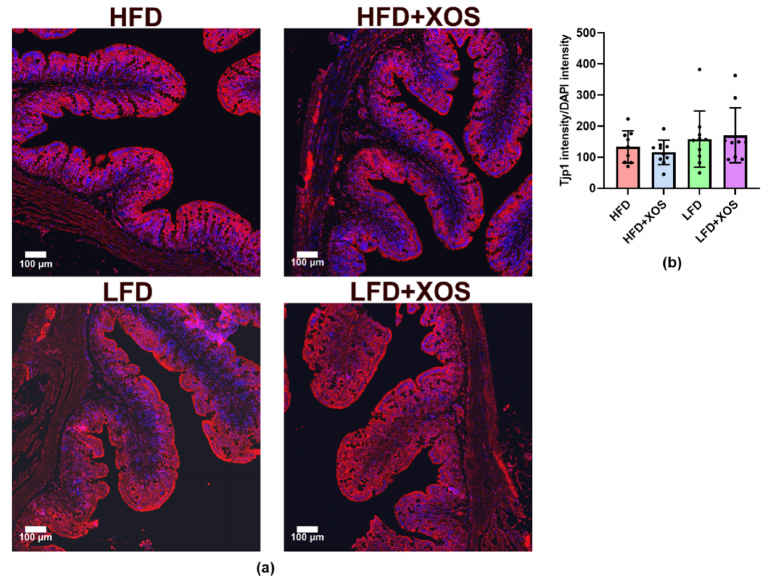
Figure 8. The intestinal Tjp1 did not differ between the diet groups. ( a ) The histological images were taken with Zeiss laser scanning microscopy (LSM) 700 and 20 x Plan-Apochromat 20 x/0.8 M27 objective. Tjp1 is shown with red label and 4 ′ ,6-diamidino-2-phenylindole (DAPI) in blue. The scale bar is 100 µM; ( b ) The bars in the graph represent the expression of Tjp1 counted as its intensity using Image J adjusted to the intensity of DAPI. n = 9–10/diet group. The different data points are shown with black dots. As mentioned, F. prausnitzii is reported to exert anti-inflammatory functions, for which we were interested in studying whether its increased abundance was associated with decreased systemic inflammation. Of the nine cytokines that were analyzed, only three were detected in rats, namely interleukin(IL)-10, IL-12 and tumor necrosis factor- α (TNF α ). XOS supplementation and thus higher abundance of F. prausnitzii were not associated with changes in the levels of these cytokines (Figure 9). TNF α was under the detection limit, i.e., <2.72 pg/mL in the HFD groups, and was detected in three out of ten rats in the LFD groups. Thus, the effect of diet on TNF α was not definable. The HFD diminished the serum level of anti-inflammatory IL-10 (F (1, 33) = 18.0, p < 0.001) (Figure 9). Due to the importance of pathways that activate IL1 family cytokines in the development of non-alcoholic fatty liver disease (NAFLD), we also analyzed the expression of IL1 β mRNA in the liver. No effects of the diets were found on the mRNA expression (Figure 9).